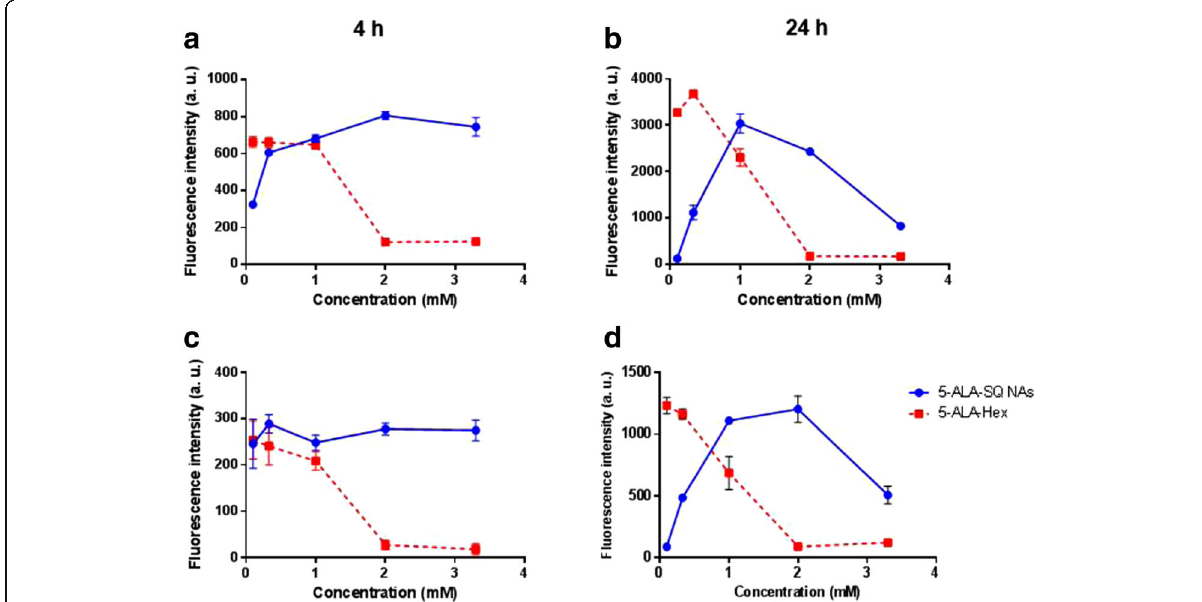
Fig. 5 Dose-response curves. Concentration-dependent PpIX accumulation with 5-ALA-SQ NAs (blue) and 5-ALA-Hex (red) in PC3 ( a , b ) and U87MG ( c , d ) cells after 4 h (left) and 24 h (right)